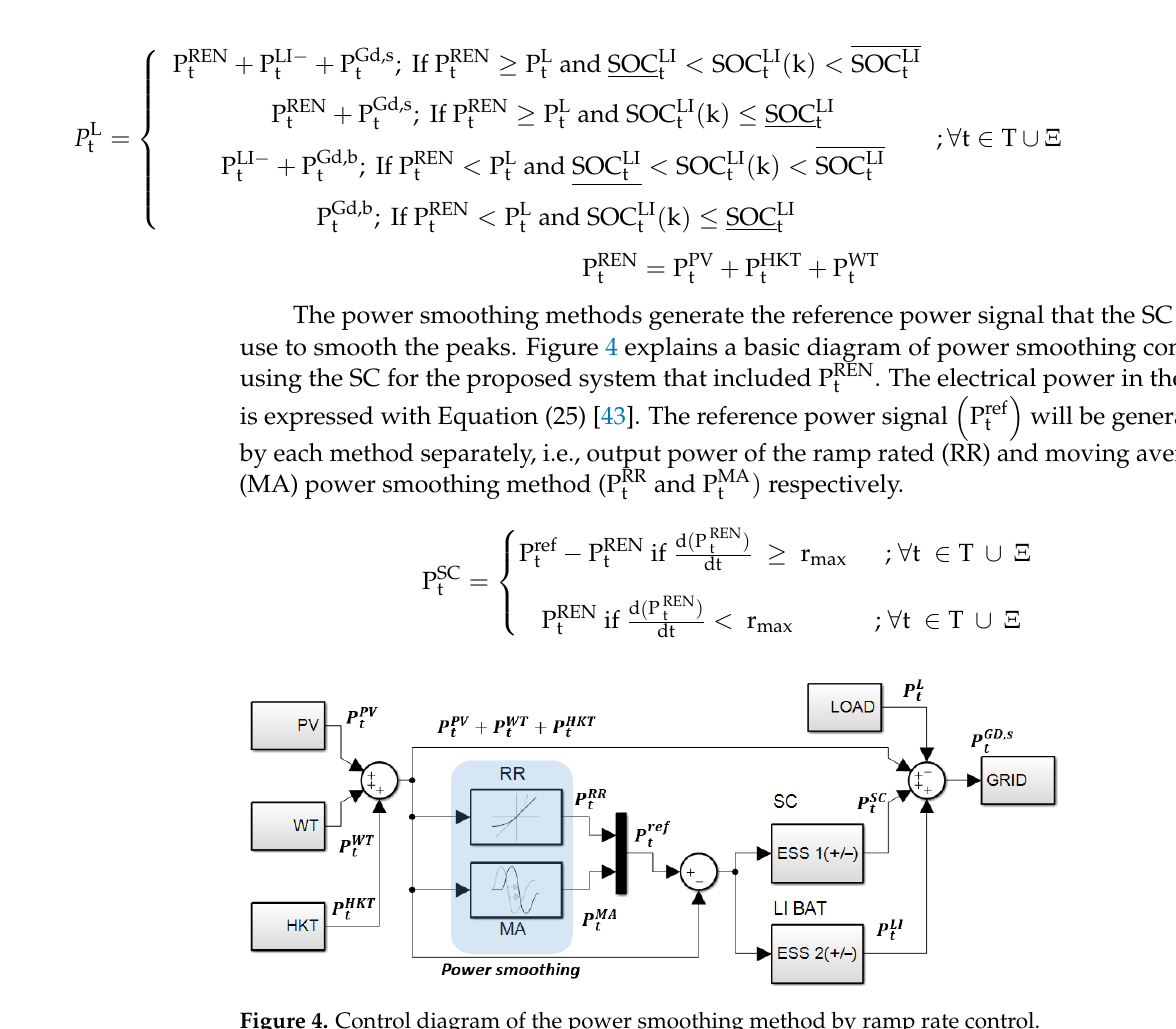
Figure 4. Control diagram of the power smoothing method by ramp rate